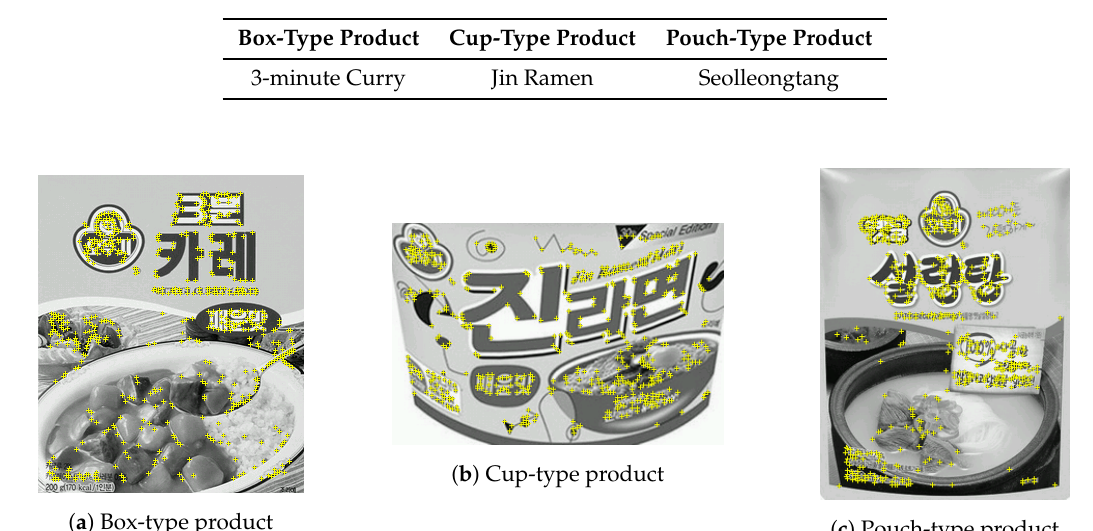
Figure 1. Target image features of product